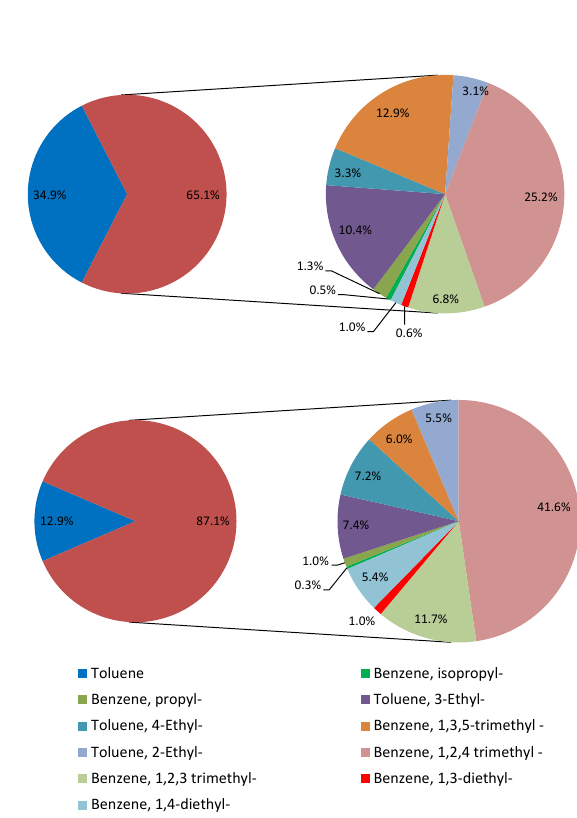
Figure 8. Monocyclic aromatic species contribution to its corre- Fig. 8. Monocyclic aromatic species contribution to its correspond- sponding [EQ Tol ]. Red: average 6 [EQ Tol ]. Blue: average toluene ing [EQ Tol ]. Red = average Σ [EQ Tol ]. Blue = Average toluene mixing ratio. (A) shows contribution for reaction with OH mixing ratio. A = Contribution for reaction with OH ([EQ Tol ] OH ). ([EQ Tol ] OH ). (B) shows contribution for reaction with NO 3 B = Contribution for reaction with NO ([ J Tol ] NO ) 3 ([ J Tol ] NO 3 3